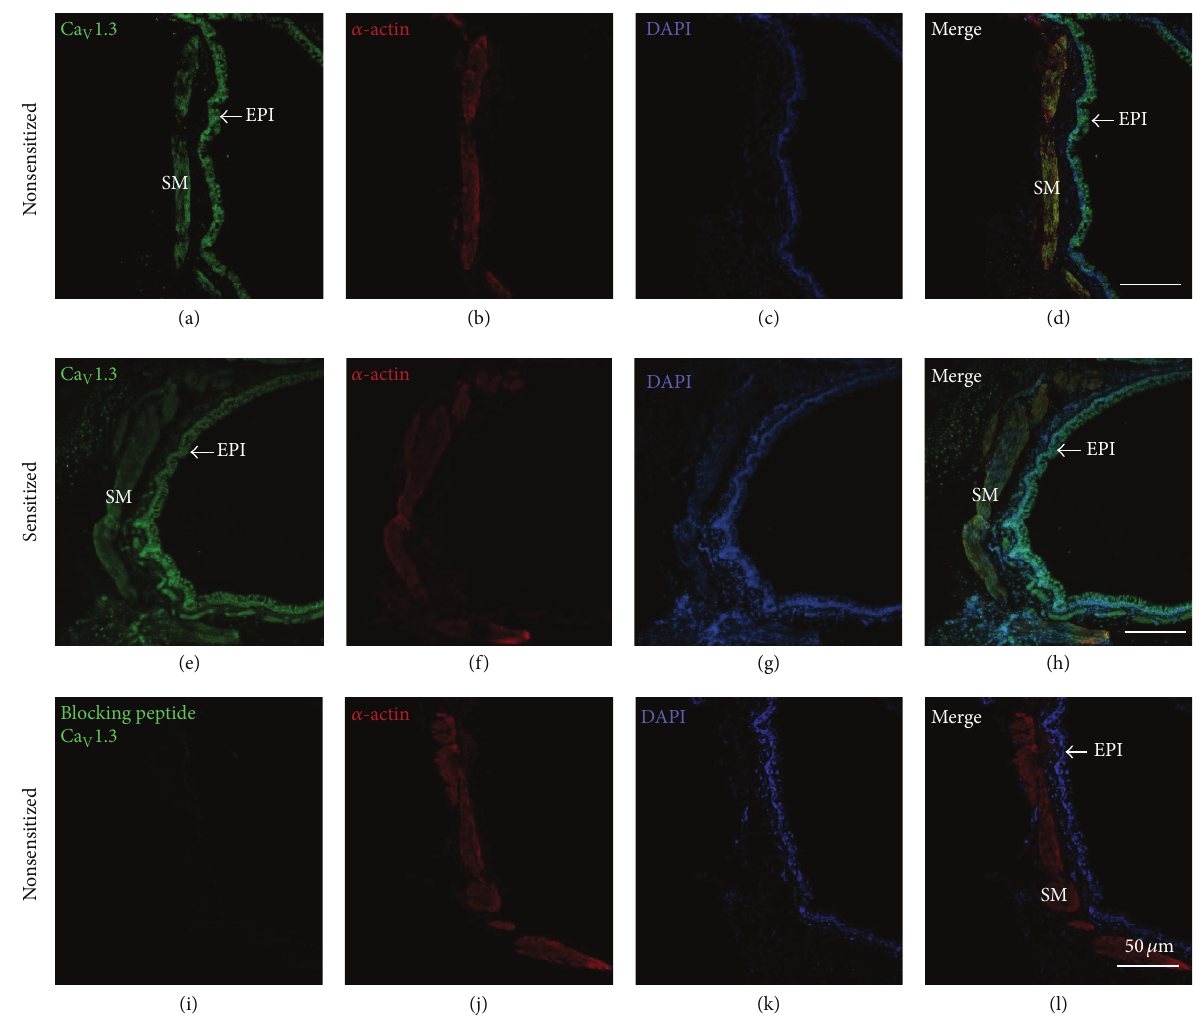
Figure 7: Immunofluorescence for Ca V 1.3 in nonsensitized and sensitized guinea pig tracheal smooth muscle. The first column shows immunoreactivity for Ca V 1.3 (stained green) in nonsensitized (a) and sensitized tissues (e); notice that Ca V 1.3 is located in the airway smooth muscle (SM) and epithelium (EPI, pointed by arrows); blocking peptide completely eliminated the fluorescence (i). The second and the third columns illustrate smooth muscle 𝛼 -actin (stained red; (b), (f), (j)) and cell nuclei (DAPI, stained blue; (c), (g), (k)). The last column depicts merged images of the former three columns ((d), (h), (l)). In these merged images, Ca V 1.3 is seen to be colocalized with 𝛼 -actin (stained yellow) on the smooth